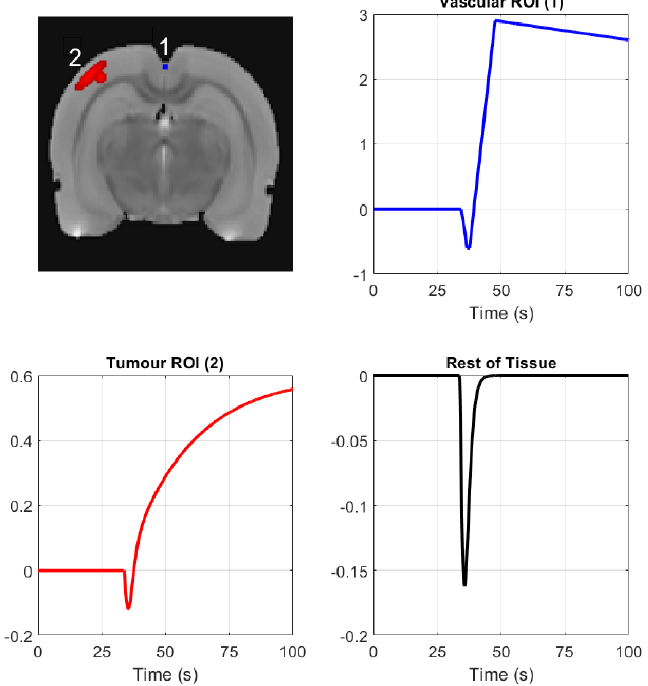
Figure 1. Vascular and tumor regions and the three template signals used in the simulation. ( Top left ) The simulated image with the vascular region of interest (ROI) marked in blue and labeled ‘1’, and the tumor ROI marked in red and labeled ‘2’. ( Top right ) Simulated vascular ROI signal template. ( Bottom left ) Simulated tumor ROI signal template. ( Bottom right ) Simulated signal template in the rest of the tissue. Each image pixel was multiplied with the corresponding template and the result was added to the image to create the simulated time